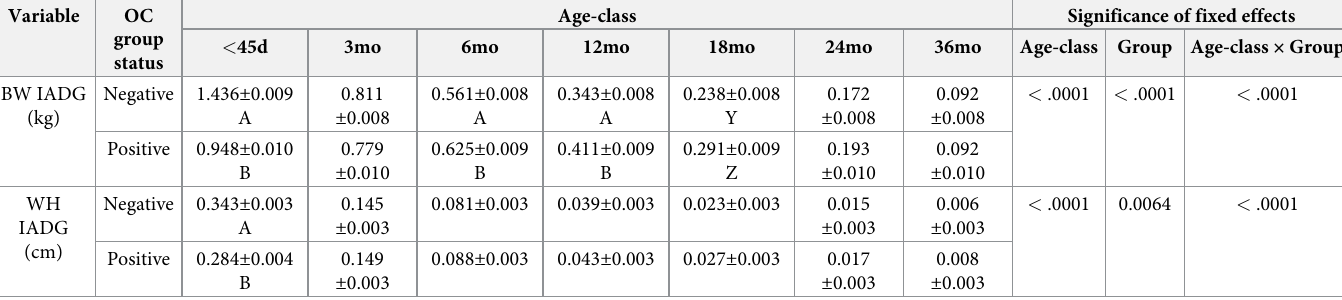
Table 4. Body weight and withers height instantaneous average daily gain of Lusitano horses (n = 31) from birth to 36 months of age according to radiographic sta- tus (negative vs . positive OC).